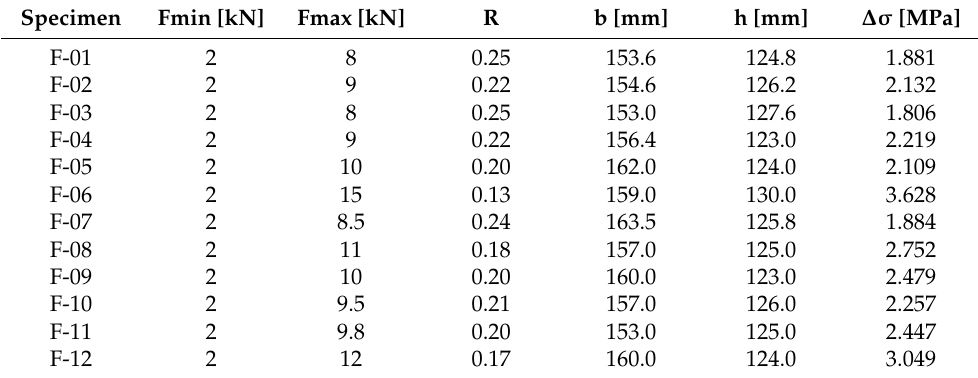
Table 3. Test parameters.